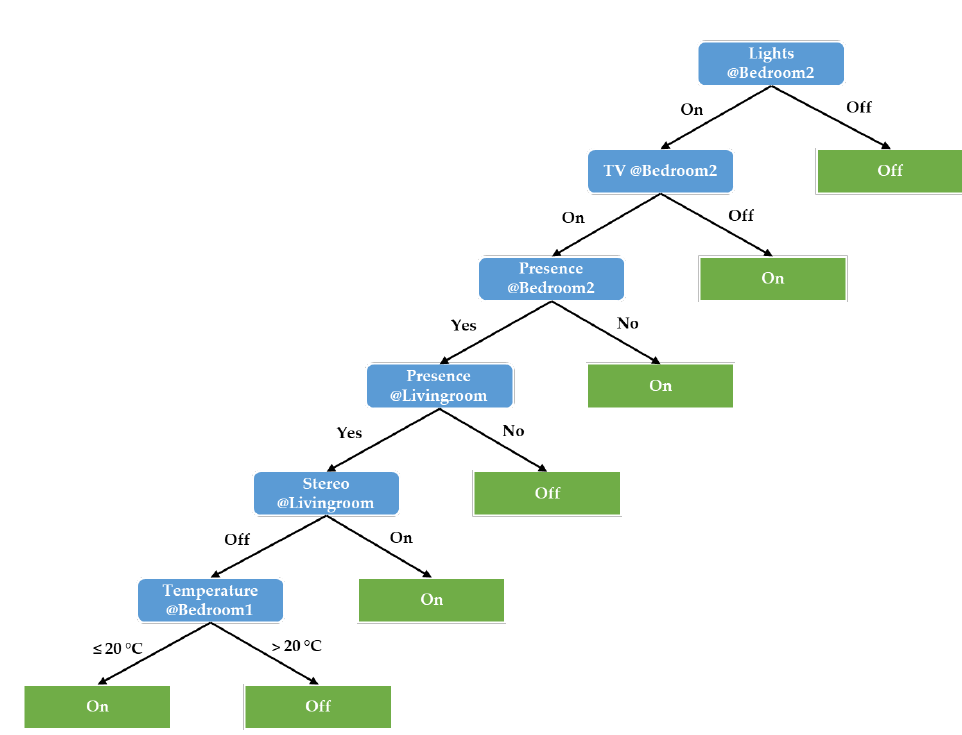
Figure 7. Resulting decision tree for living room lights.